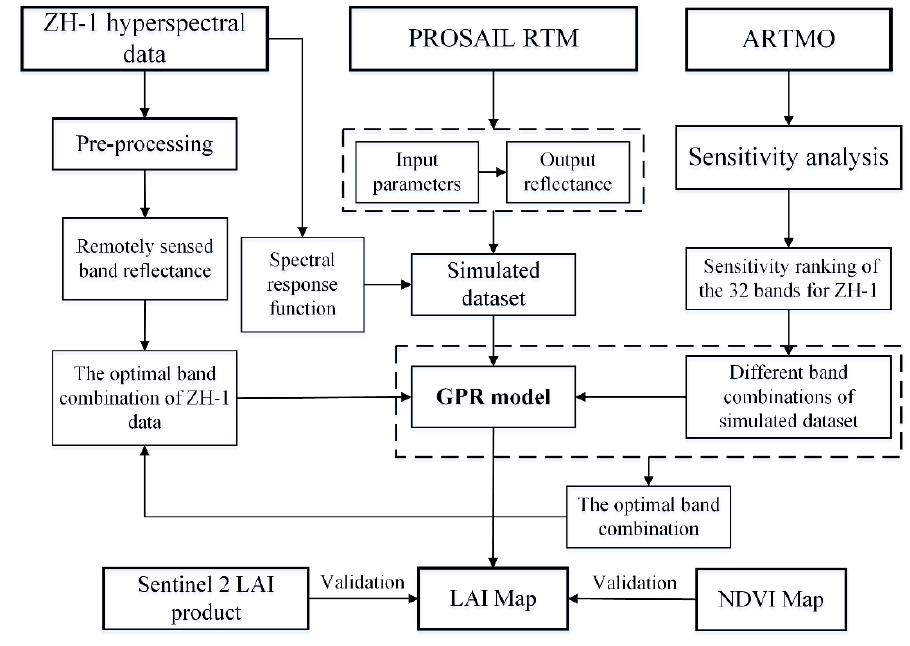
Figure 2. The workflow of this study.